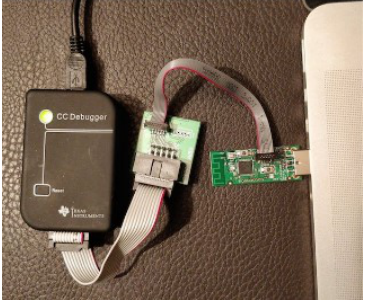
Figure A1. CC debugger + USB dongle.